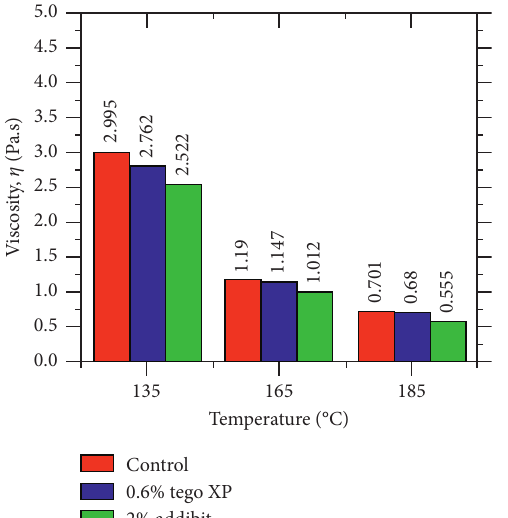
Figure 6: Viscosity and shear rate of CRM asphalt with and without WMA additives at (d) viscosity-temperature at 1000 shearing rate (1/s).